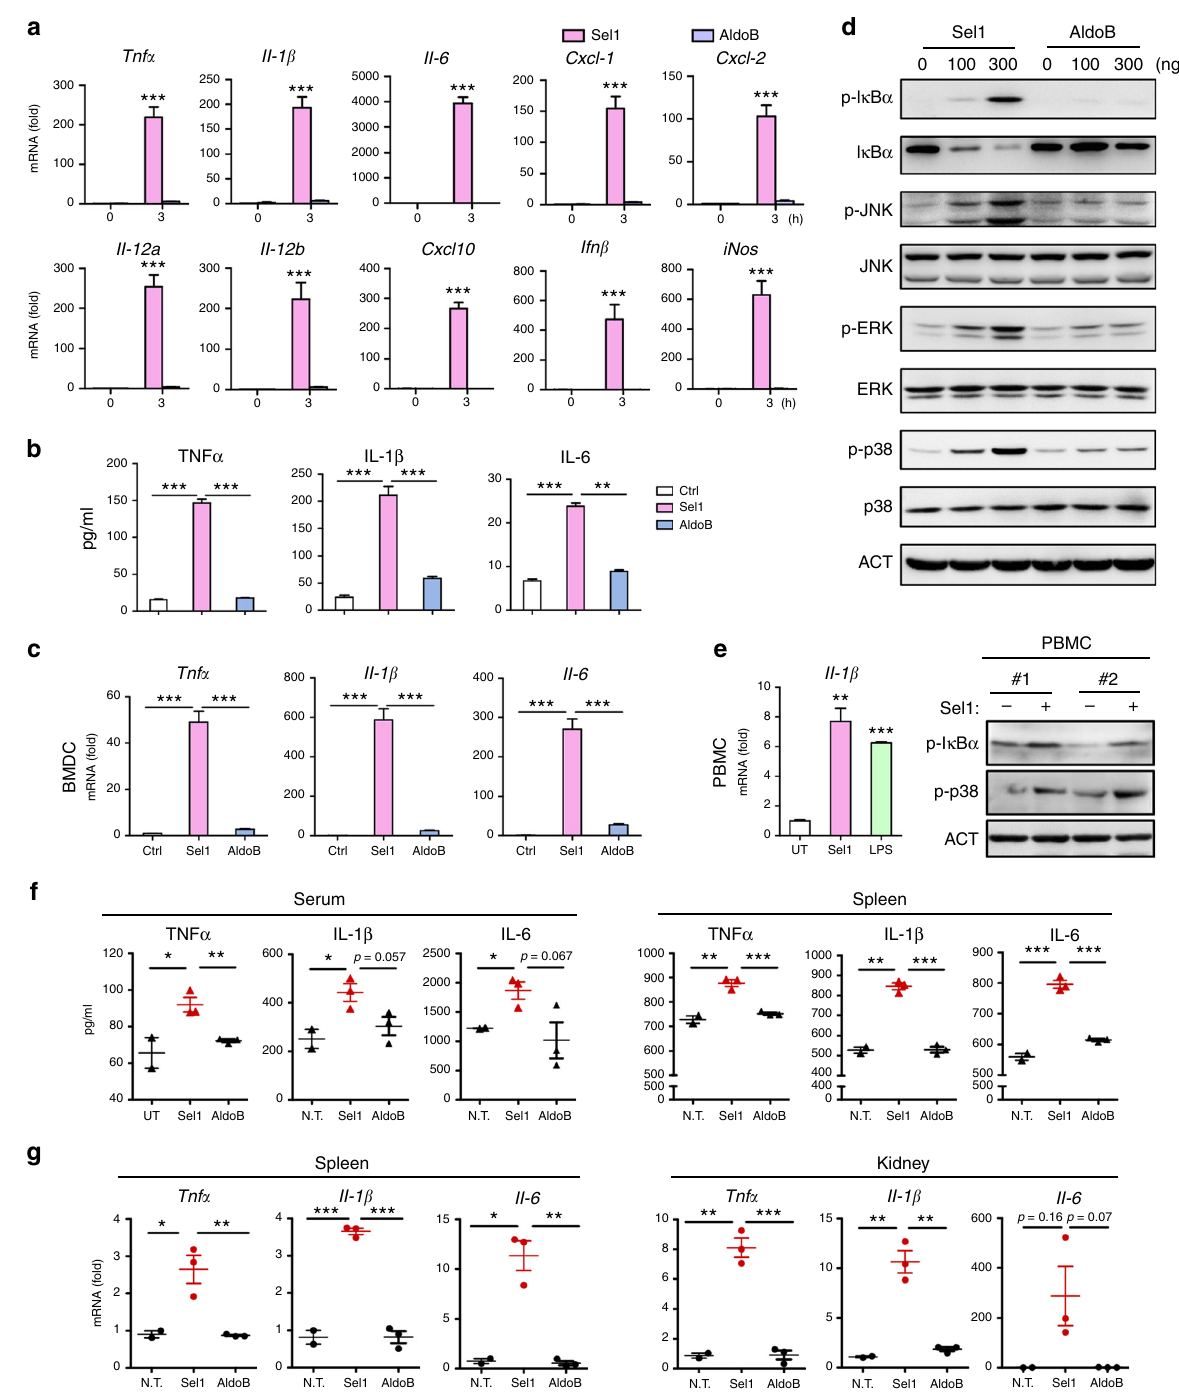
Fig. 2 Sel1 induces proin fl ammatory responses in immune cells. a , b Bone marrow-derived macrophages (BMDMs) were stimulated with puri fi ed recombinant Sel1 and AldoB proteins (300 ng/ml) for 3 h, and the induction of proin fl ammatory genes was measured by real-time quantitative PCR (qRT- PCR) ( a ) or enzyme-linked immunosorbent assay (ELISA) ( b ), respectively. c Bone marrow- derived dendritic cells (BMDCs) were stimulated with Sel1 or AldoB proteins (300 ng/ml) for 3 h, and the cytokine response was assessed by qRT-PCR. d BMDMs were stimulated with various amounts of Sel1 and AldoB proteins for 30 min, and the activation of nuclear factor (NF)- κ B and mitogen-activated protein kinases (MAPKs) were examined by western blotting. e Peripheral blood mononuclear cells (PBMCs) were stimulated with Sel1 (300 ng/ml) or lipopolysaccharide (LPS; 100 ng/ml) for 3 h, and Il-1 β production was measured by qRT-PCR (left), or PBMCs from two individuals were stimulated with Sel1 (300 ng/ml, 30 min) and the signaling pathways were analyzed by western blotting (right). f , g Wild-type C57BL/6 mice were injected with puri fi ed Sel1 or AldoB proteins, respectively, and 6 h later, the serum and tissues were obtained for cytokine detection (6 – 8 weeks old, male, 150 μ g protein/mouse, n = 3). Tumor necrosis factor- α (TNF α ), interleukin (IL)-1 β , and IL-6 proteins in serum (left) and spleen (right) was measured by ELISA ( f ). Tnf α , Il-1 β , and Il-6 mRNA levels in spleen (left) and kidney (right) were assessed by qRT-PCR ( g ). Data represent the average expression levels of each gene from at least two ( a – c , e – g ) independent experiments. Data are representative of at least three ( d ) independent experiments with similar results. Bars, mean ± SEM; * p < 0.05, ** p < 0.01, *** p < 0.001, by Student ’ s t